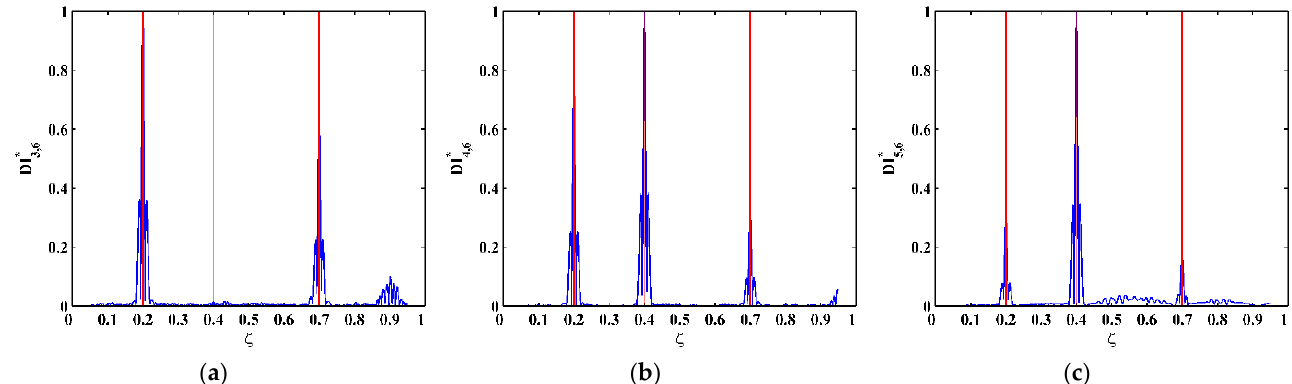
4 [ ] x λ for the ( a ) third, ( b ) fourth, and ( c ) fifth mode shapes.